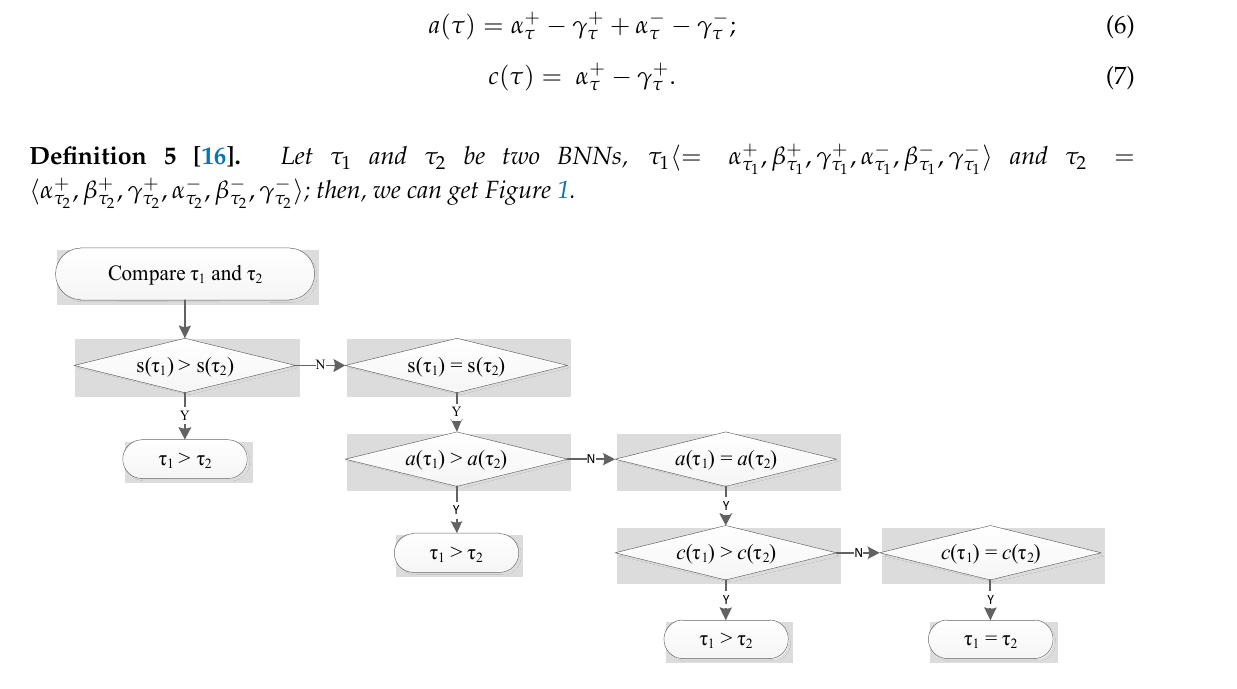
Figure 1. The relationship between 𝜏 (cid:2869) and 𝜏 (cid:2870)